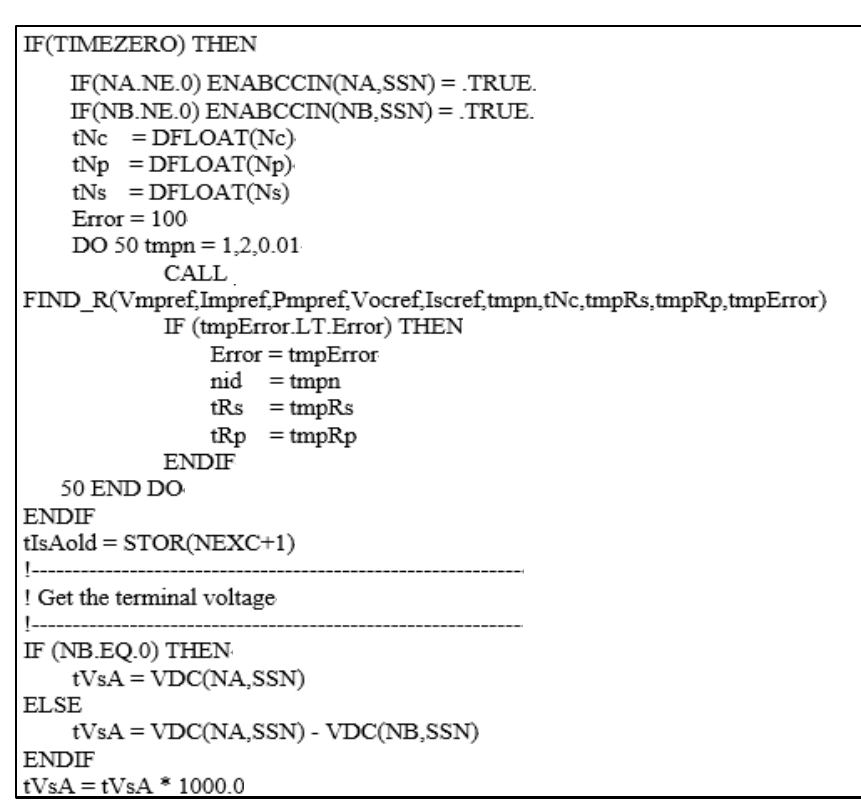
Figure 5. Fortran code for the terminal voltage and initialization of the PV model.